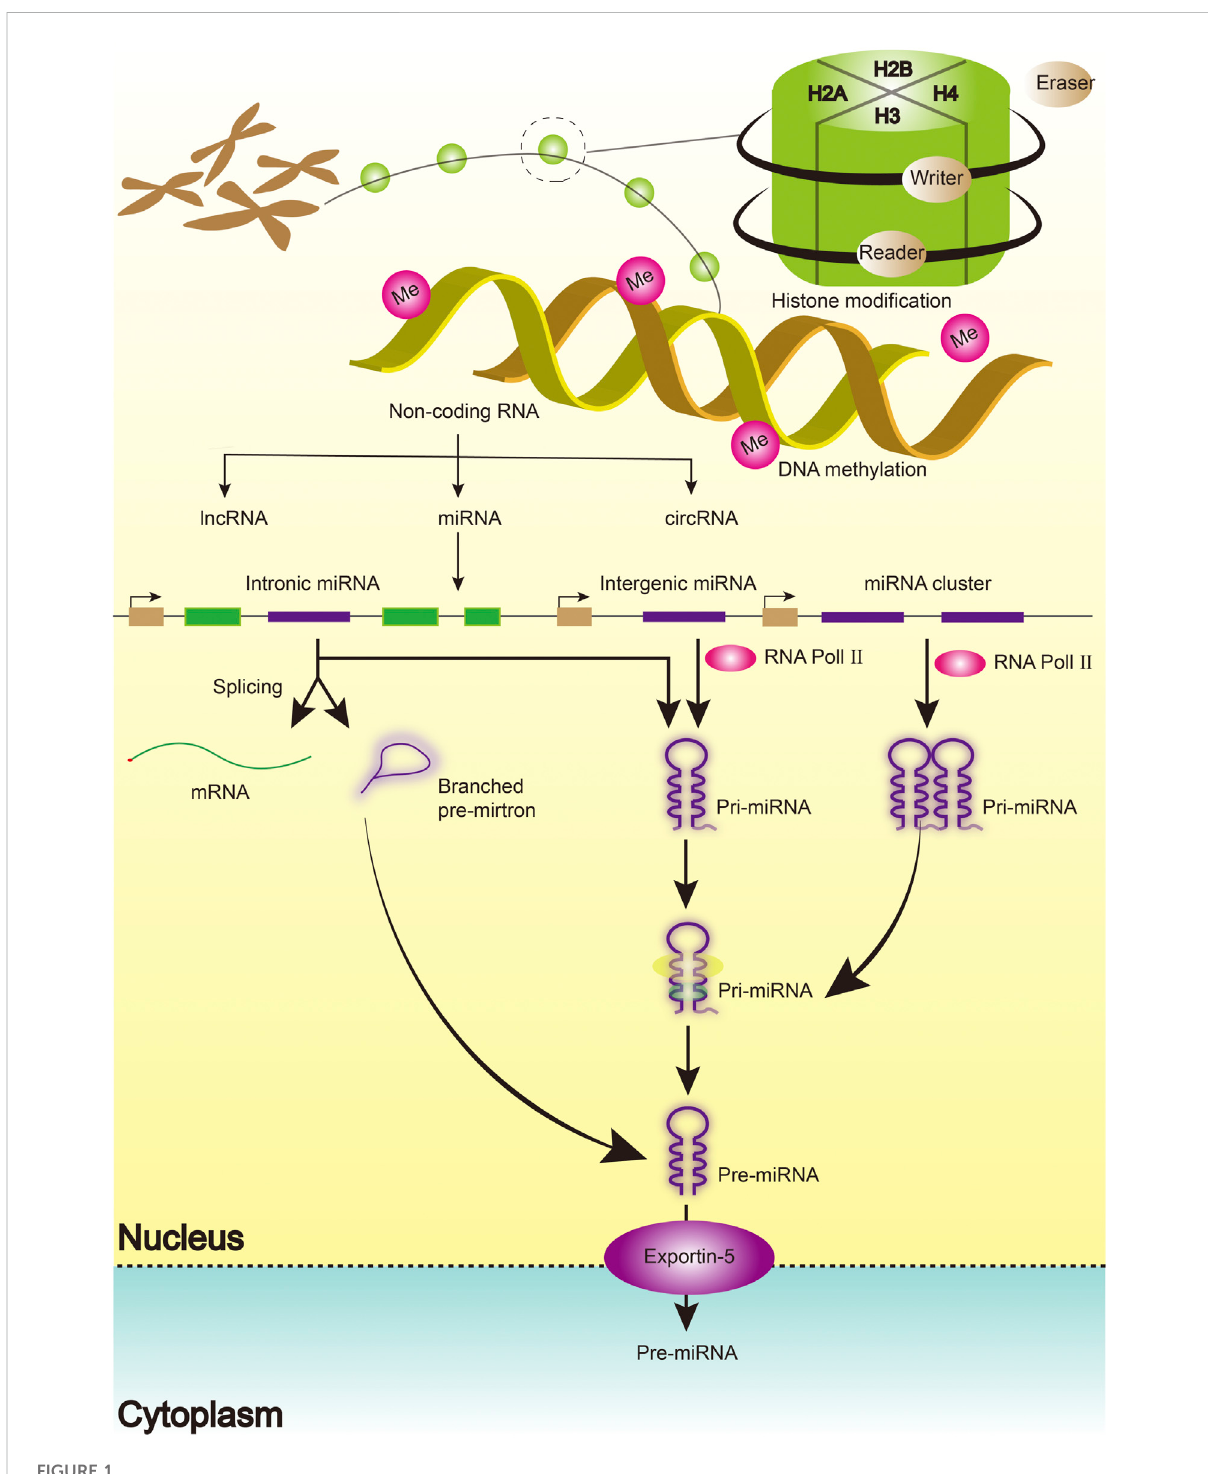
FIGURE 1 The Biogenesis of